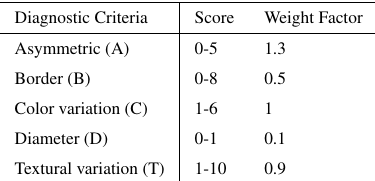
Table 1. The Proposed diagnostic